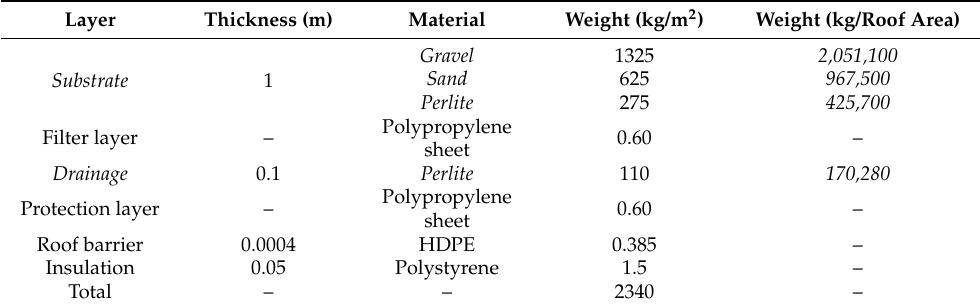
Table 3. Materials required for the conventional green roof.